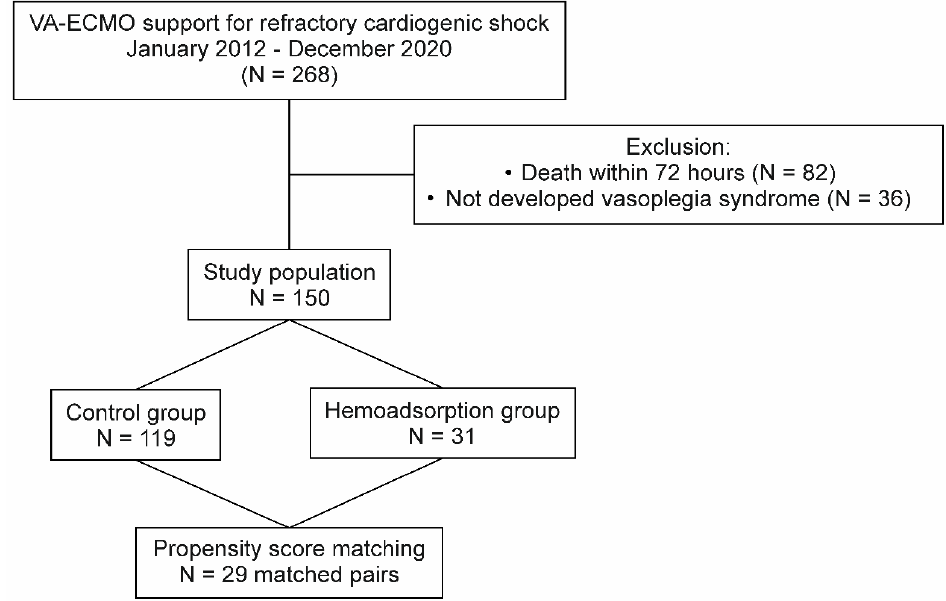
Figure 1. Patient selection flowchart. VA–ECMO: venoarterial extracorporeal membrane oxygena- tion.